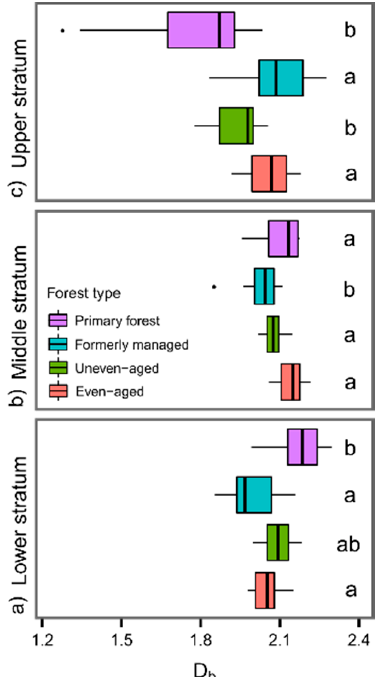
Figure 3. Box-and-whisker plots showing the box-dimension (D b ) for the lower ( a ), middle ( b ), and upper forest stratum ( c ) depending on the forest types. The different letters indicate significant differences between the different forest types at p < 0.05. Sample sizes for the different forest types were even-aged managed (EA): n = 12, uneven-aged managed (UEA): n = 8, formerly managed (FM): n = 11, and primary forest (PF): n = 8. Black horizontal lines indicate the median. In the upper forest stratum, D b was significantly lower in the primary forests than in the even-